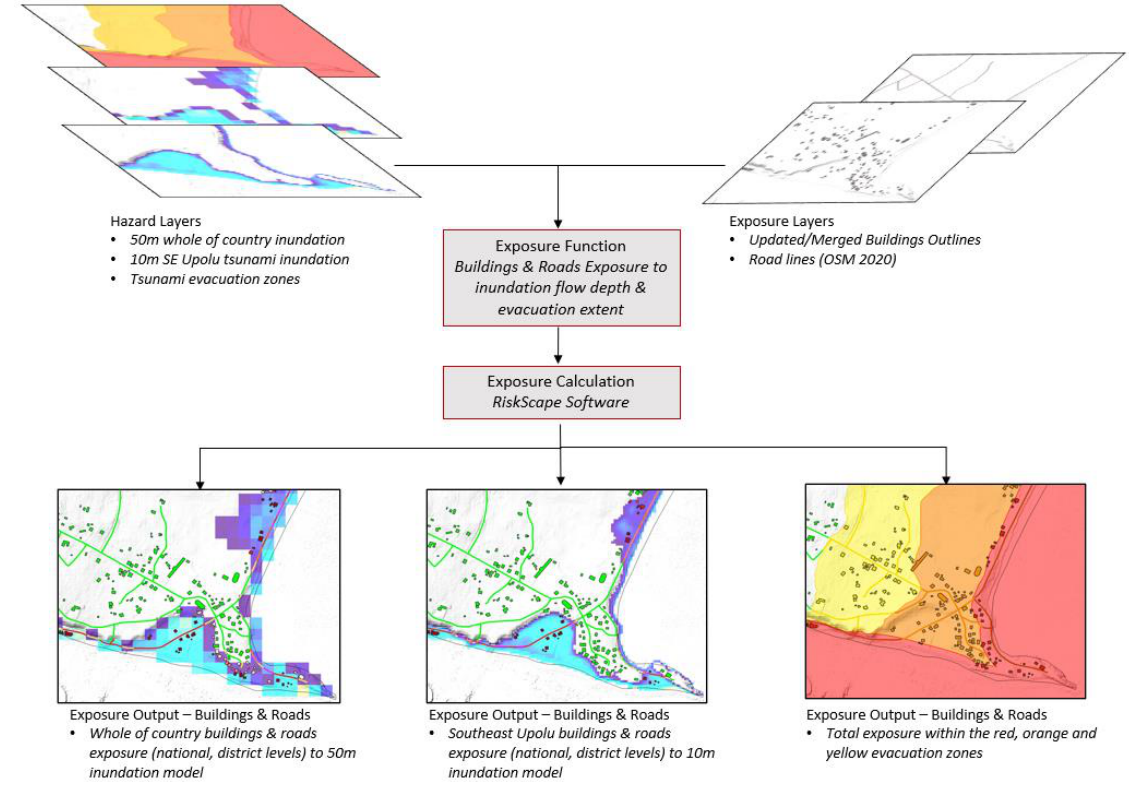
Figure 3. Schematic representation of the RiskScape exposure model framework and workflow applied in this study. Hazard layers depicting maximum extent and flow depths at 50 and 10 m grid resolution [14] and evacuation zones [20] are combined with exposure layers (distribution of buildings and road features in districts and villages) to enumerate the sum of the exposed features. The RiskScape analysis framework is described by [22] and has been previously demonstrated in several inundation-related impacts and exposure analyses (e.g., [6,19,46]).